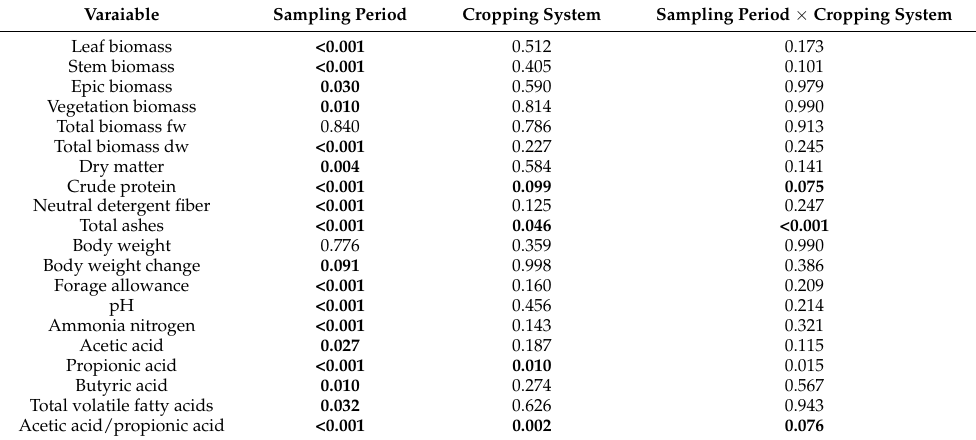
Table 2. p values from combined analysis of variance for the biomass and nutritive value of the stubble of wheat grown under conventional tillage and no-tillage systems, and the body weight and rumen fermentation characteristics of ewes grazing on the stubbles.